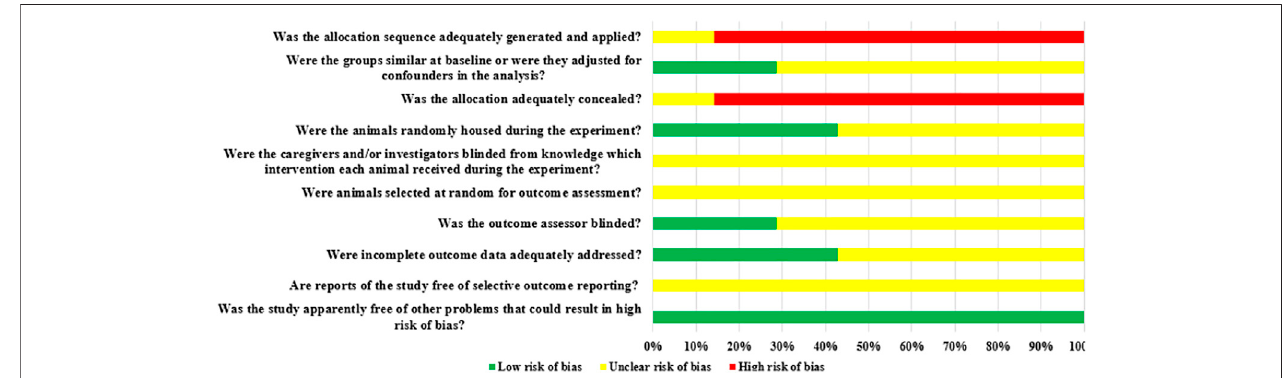
FIGURE 3 | Risk of bias of each item of the SYRCLE tool for overall included studies. Each risk-of-bias item presented as percentages across all included studies, which indicated the proportion of different level risk of bias for each item.